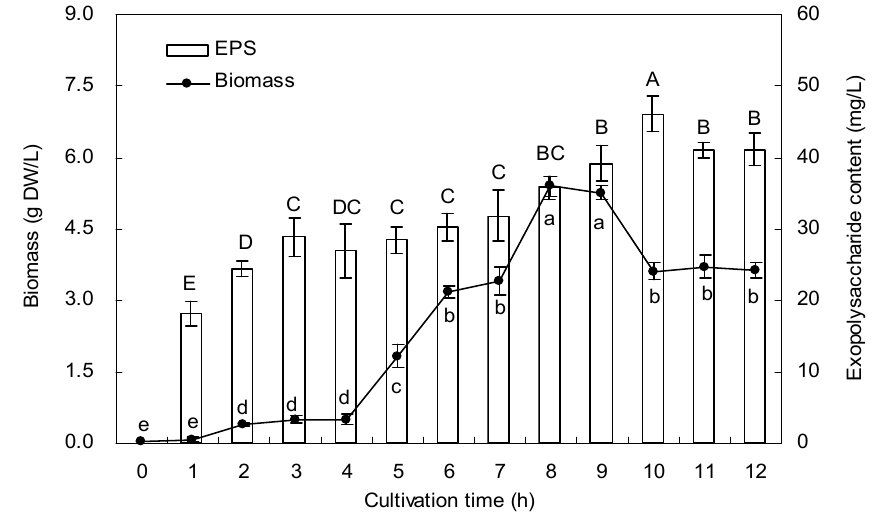
Figure 2. Time courses of bacteria biomass and EPS content in liquid cultures of Bacillus cereus SZ1 . Data are mean ± S.D. of three replicates. The letters indicate the significant difference ( p < 0.05) between the data of the different cultivation time.